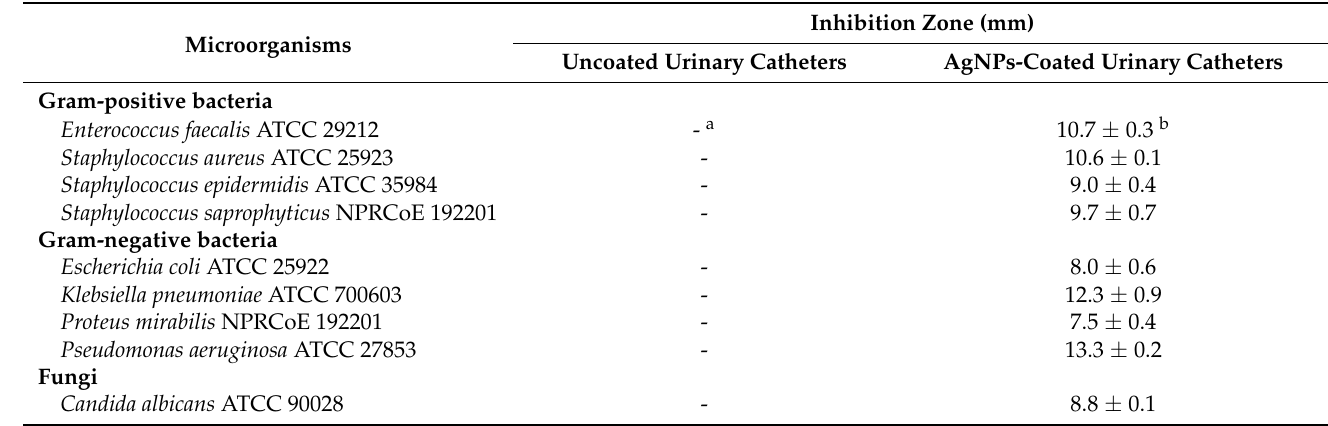
Table 1. Inhibition zone of AgNPs-coated urinary catheter against pathogenic microorganisms.